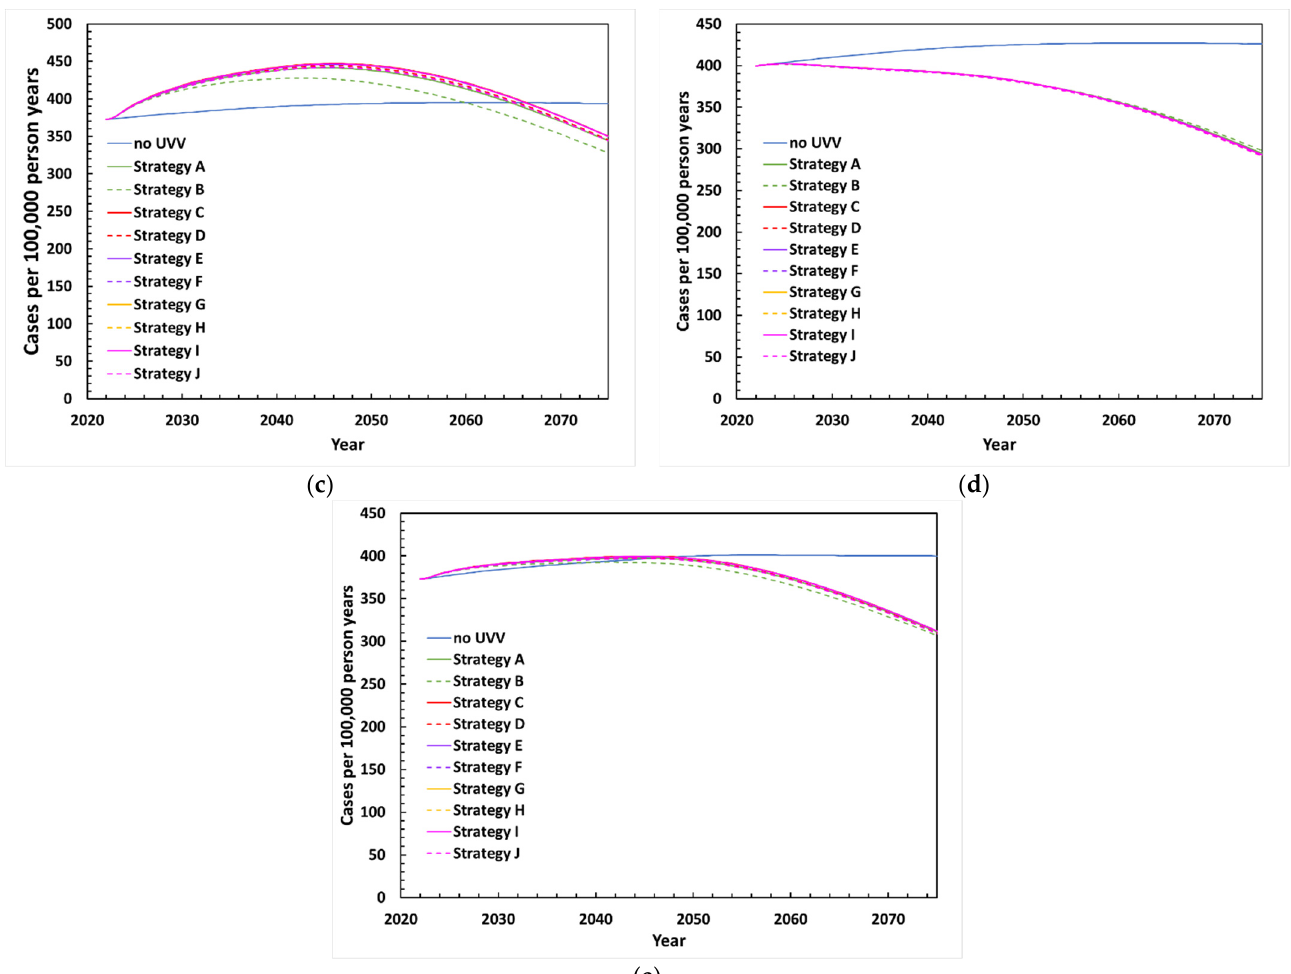
Figure 3. Projected incidence of HZ between 2022 and 2072 with various UVV strategies under ( a ) base-case scenario, ( b ) exogenous boosting scenario EB1 with waning period of HZ immunity of 24.4 years and age dependent effective contacts (75%, 71%, 57%, and 32% for <60, 60–69, 70–79, and ≥ 80 years old, respectively), ( c ) exogenous boosting scenario EB2 with waning period of HZ immunity of 81.3 years and 100% effective contacts, ( d ) exogenous boosting scenario EB3 with waning period of HZ immunity of 81.3 years and 0% effective contacts, ( e ) HZ vaccination scenario.